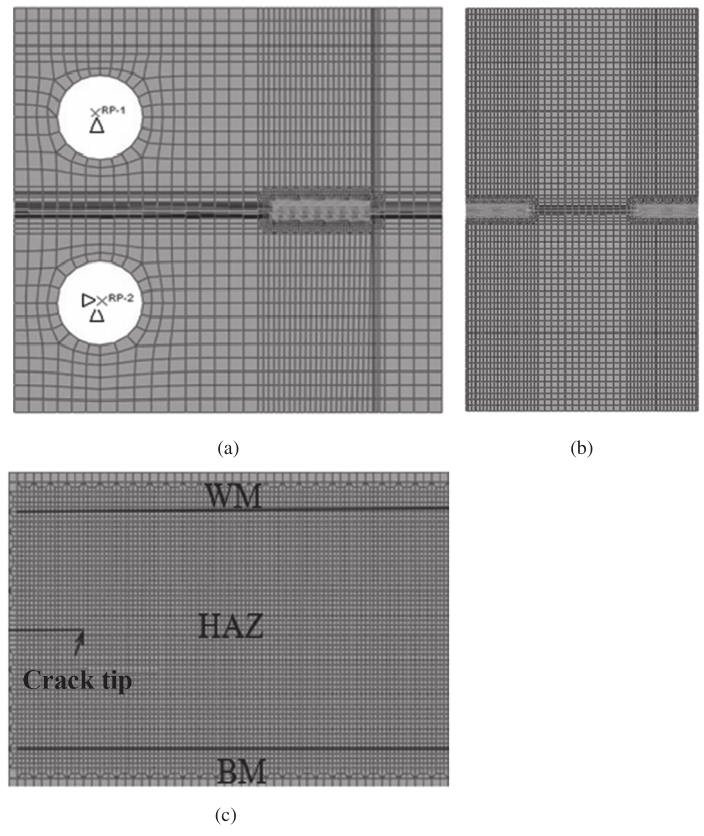
Figure 2: The welded joint FE models of CT specimen (a), M(T) specimen (b) and local meshes around the initial crack tip